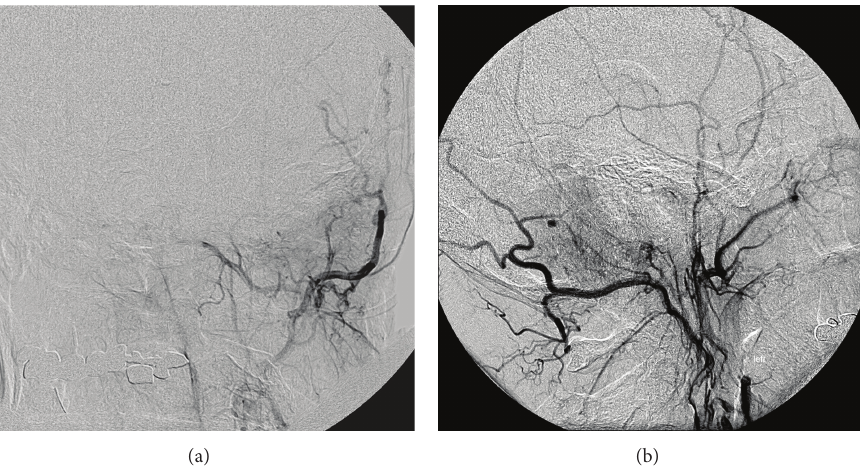
F 2: Digitally subtracted angiography (a) AP and (b) lateral projections demonstrating a slight tumor blush from an external carotid